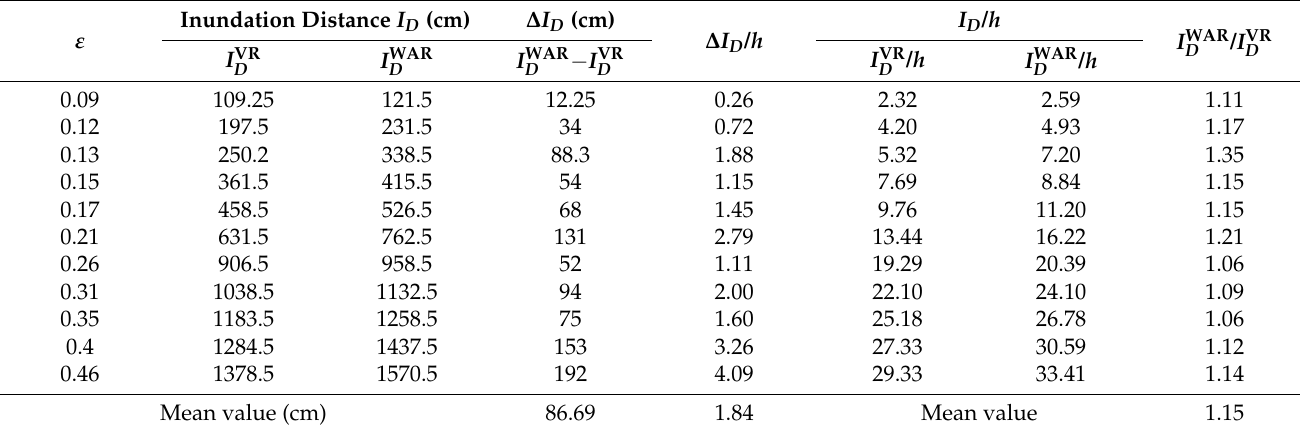
Figure 25. Comparison of inundation distance due to 𝜀 at the VR and WAR. Table 3. Inundation distances due to ε